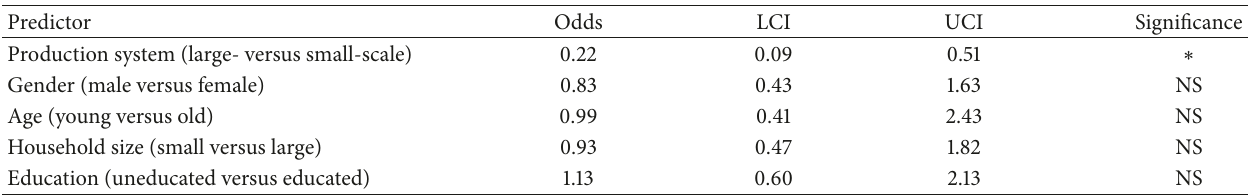
Table 5: Odds ratios estimates and lower (LCI) and upper confidence interval (UCI) of farmers being concerned about milk quality.